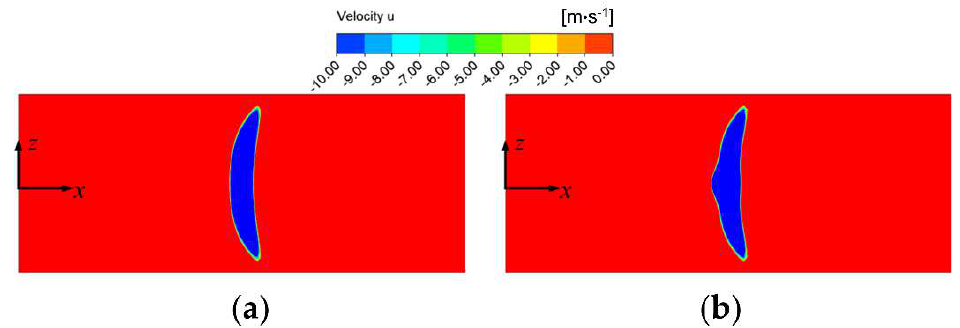
Figure 18. The form of separation zone at y = 0 cross section: ( a ) base flow field; ( b ) actuation flow field.